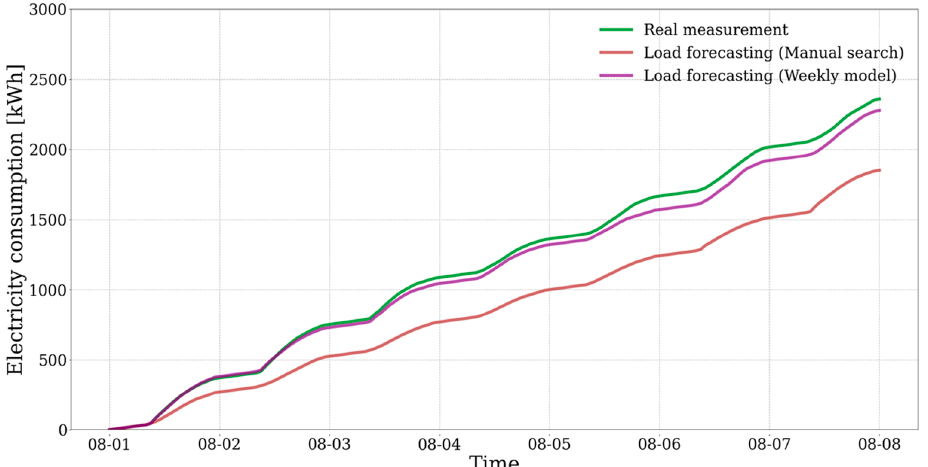
Figure 10. Load forecasting result with weekly model and simulation data. Table 4. Error for test data with simulation